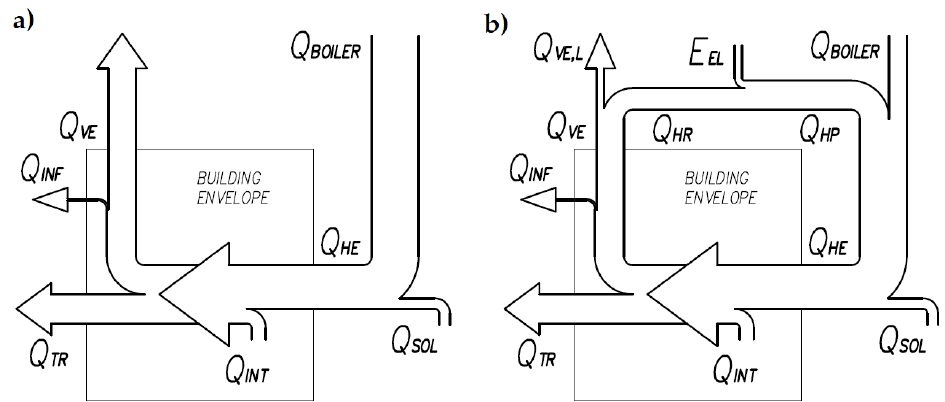
Figure 1. Comparison of energy balance of a building with exhaust ventilation ( a ) without heat recovery and ( b ) with heat recovery using an electric compressor heat pump and its use for space heating. EL—electric; HP—heat pump; HE—heating; SOL—solar gains; INT –internal gains; TR—transmission; INF—infiltration; VE—ventilation; VE,L—ventilation loss; HR—heat recovery.